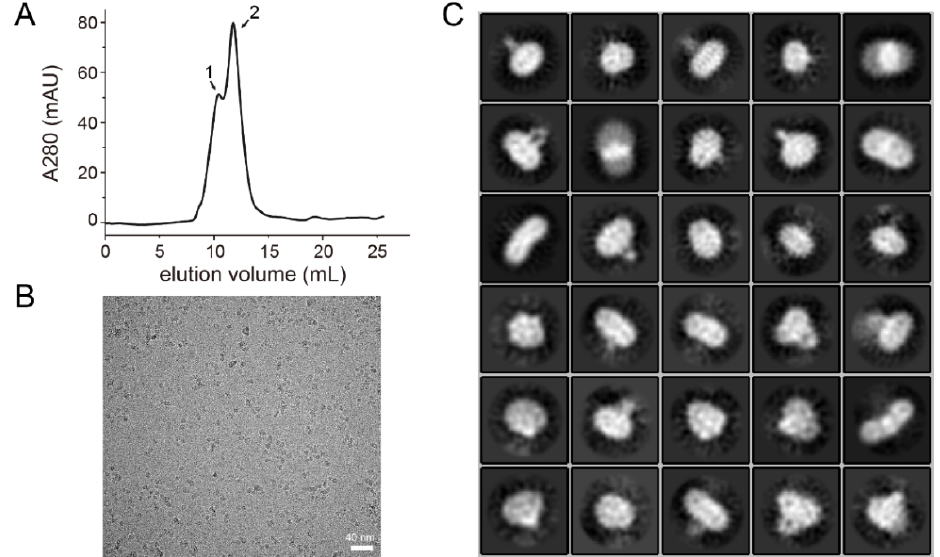
Figure 4. Characterization of hDHHS3- Δ 35 by 200 kV cryo-EM measurements. ( A ) Representative size-exclusion chromatography profile of hDHHS3- Δ 35 purified in GND micelles. At least two states were detected in SEC, possibly referring to hDHHS3- Δ 35 dimers (peak 1) and hDHHS3- Δ 35 monomers (peak 2). ( B ) A representative micrograph of the hDHHS3- Δ 35 protein sample. ( C ) Two- dimensional (2D) class averages of hDHHS3- Δ 35 in GDN micelles.